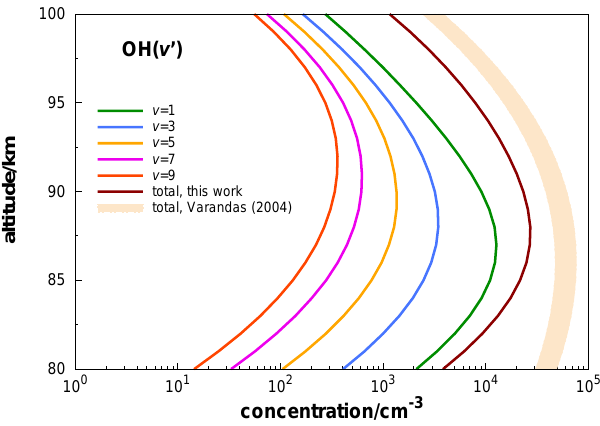
Fig. 3. Vertical profiles of vibrationally excited hydroxyl radical. The shaded area refers to the model reported elsewhere (Varandas, 2004b, 2005a) for the total concentration using satellite data taken in the equatorial region.